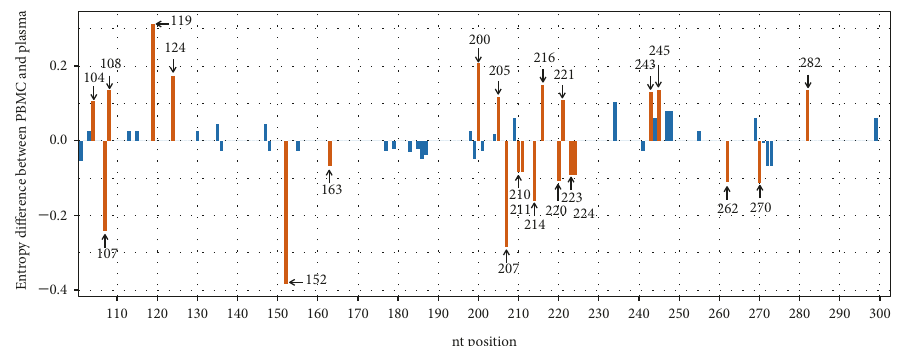
Figure 2: Entropy differences between the PBMC and plasma. Entropy differences between sequences (nt 100 to 300 of the HCV IRES) derived from PBMCs (n=225) and plasma (n=225). Each bar represents the entropy difference at a single nucleotide position. Significant differences between the entropy of PBMC and plasma are indicated by orange bars while no significant differences are indicated by blue bars. The results were generated using a Perl script and the figure was produced in R software programming